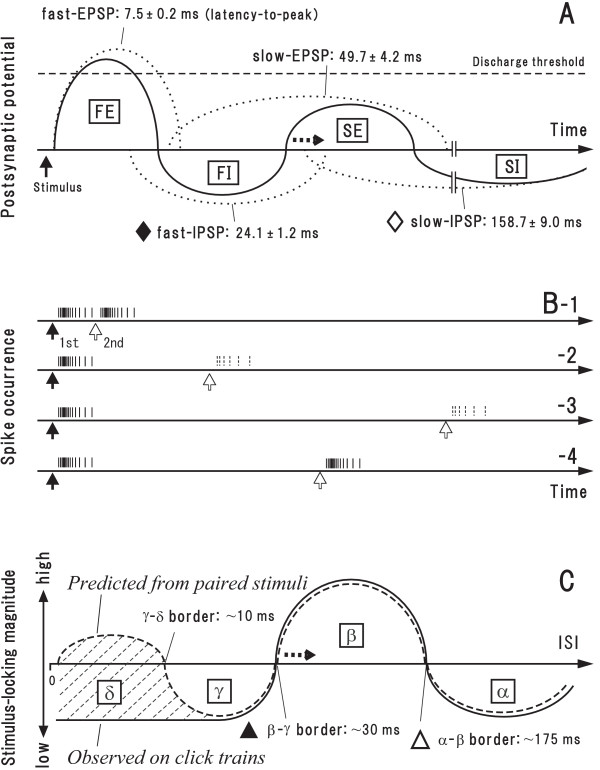
A: Scheme for a sequence of EPSPs and IPSPs (broken curves) in the AI neuron elicited by a single afferent stimulation (based on [27]). Temporal interaction between the PSPs may form four phases (solid curves) in the following order: fast excitatory (FE), fast inhibitory (FI), slow excitatory (SI), and slow inhibitory (SI) periods. Numerals represent latency-to-peak (mean ± SD). Identical time scale is applied to A-C. B: Predicted firing responses (vertical lines) elicited by paired stimuli of various ISI. When the 2nd stimulus is given during period FE (ref., A; same as followings) (-1), it would readily elicit firing responses. However, the discharge clusters elicited by the 1st and 2nd stimulus may merge together so that stimulus-locking responses, if any, would be weak. When the 2nd stimulus is given during period FI (-2) or SI (-3), it would hardly elicit firing responses and, consequently, stimulus-locking responses. When the 2nd stimulus is given during period FE (-4), it would readily elicit firing responses. The discharge clusters elicited by the 1st and 2nd stimulus may be clearly separated each other by period FI leading to intense stimulus-locking responses. C: The tMTF that derived from the prediction in B (broken curve) and the tMTF that was schematically drawn from the data of the synchronization type with band-pass tMTF (solid curve; based on Table 1). Regions α-δ correspond to those in Figure 1A-1. Enhancement of GABAA-ergic inhibition may shift the FI-SE transition point afterward (A, horizontal arrow) thus prolonging β-γ border (C, horizontal arrow).